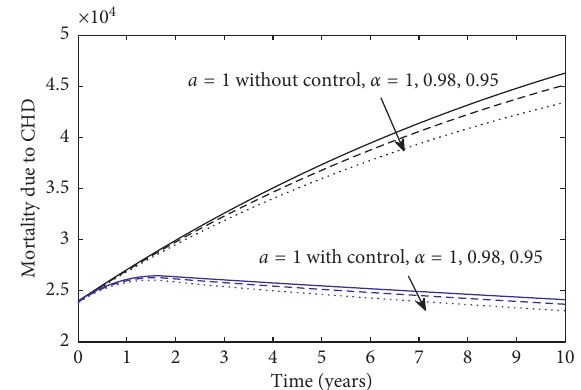
Figure 6: Mortality due to CHD, where a � 1 without control (black lines) and with control (blue lines) for α � 1 (solid line), α � 0 . 98 (dashed line), and α � 0 . 95 (dotted line).